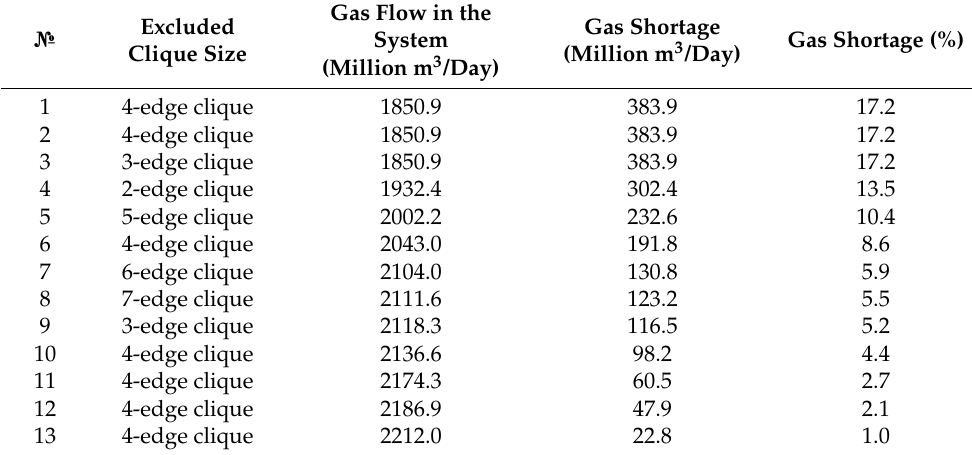
Considering that the number of cliques detected was large, Table 1 shows the cliques that caused significant damage to the gas transmission network. Table 1 clearly demonstrates that the failure of the first three cliques of the edge graph will lead to a gas deficit